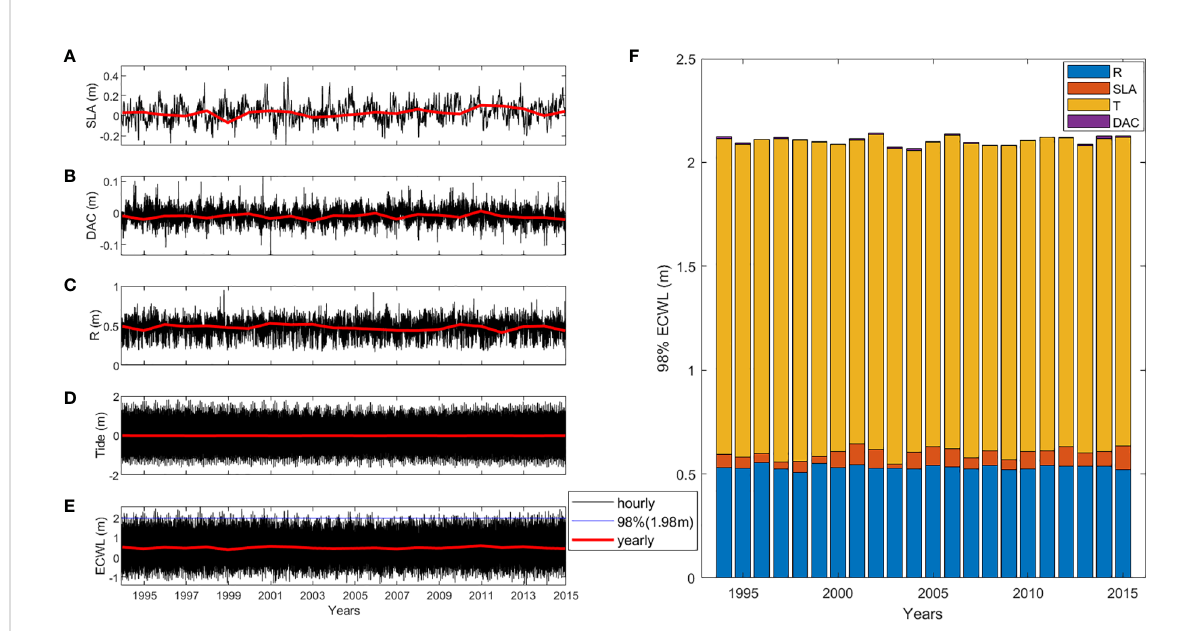
FIGURE 5 (A – E) ECWL components hourly (black) and yearly (red) timeseries and (F) contribution of each ECWL component passing the 98 percentile and potentially causing severe fl ooding in Saint-Louis between 1994 and 2015. In (F) the components are aggregated yearly during the moments overpassing the 98 percentile. Blue line in (E) stands for the 98 th percentile of the ECWL timeseries, and referred to as “ severe ”